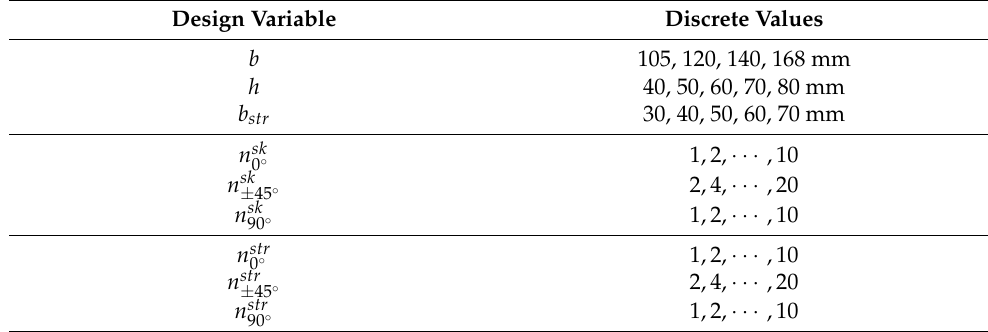
Table 1. Design variables and discrete